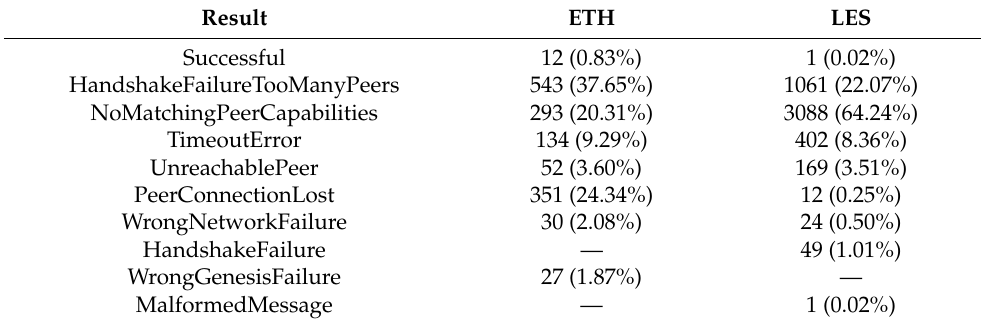
Figure 6. Memory consumption of the Aurora module measured with memory-profiler for Python. Table 2. Results of RLPx connection attempts with peers in the mainnet Ethereum